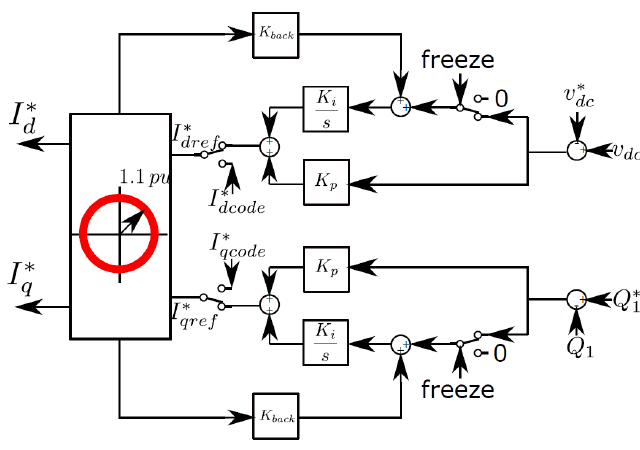
Figure 13. LVRT strategy for 850 kW voltage source converter. Table 3. Paramters of inverter for experiment verification.